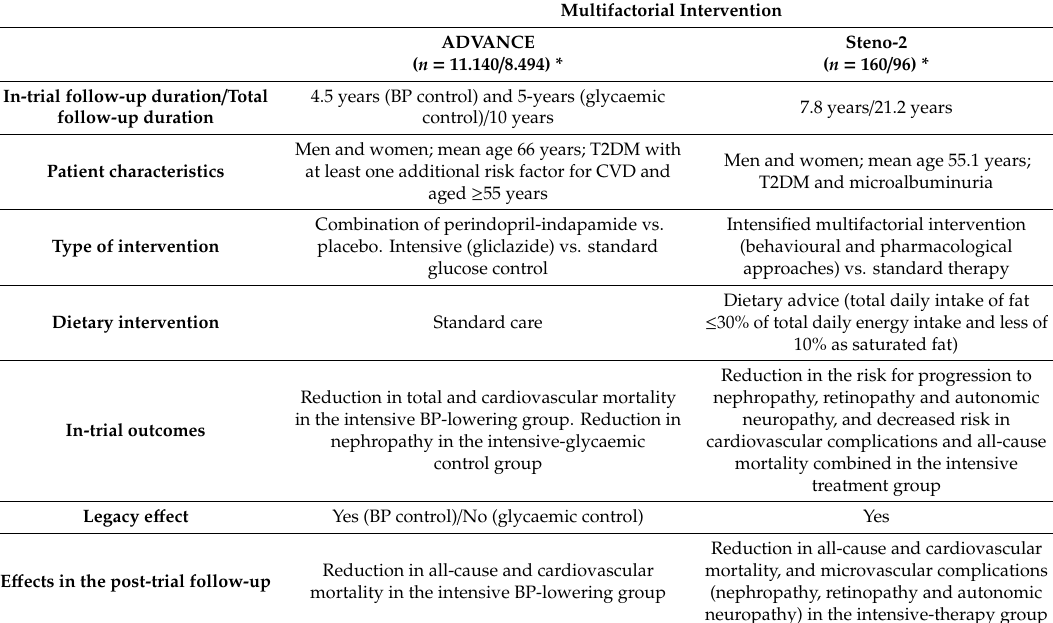
Table 4. Studies assessing the legacy e ff ect after multifactorial